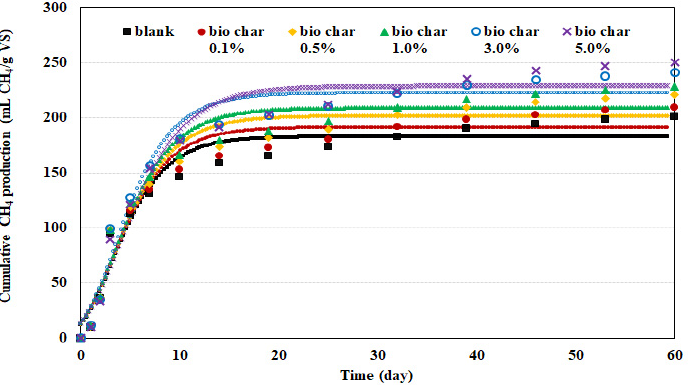
Figure 6. Comparison of the derived modified Gompertz equations using the results obtained in the current study.